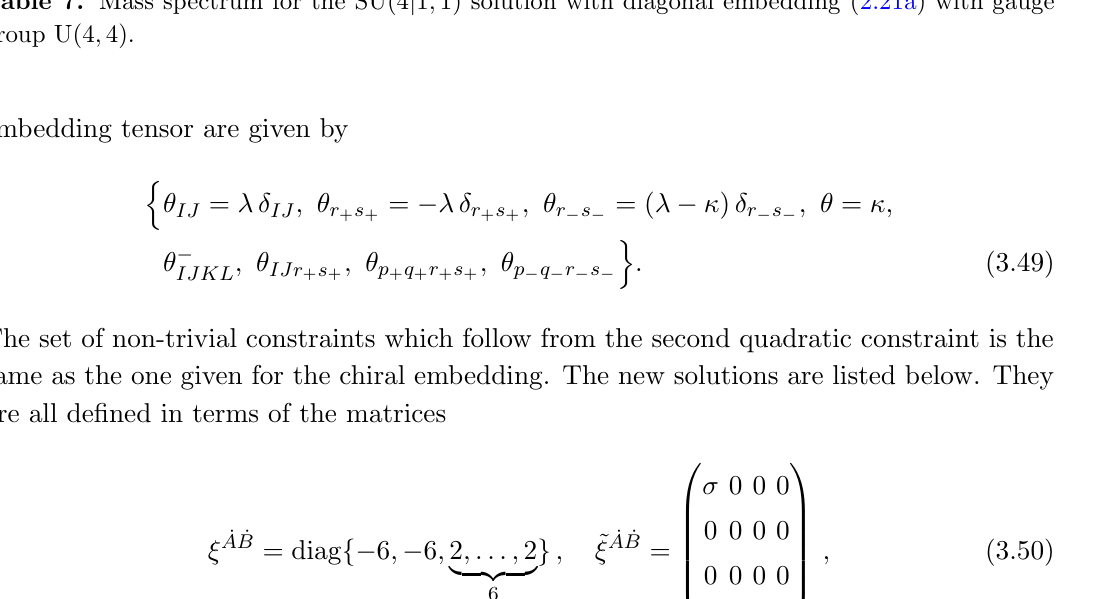
1 ; 1) solution with diagonal embedding (2.21a) with gauge j